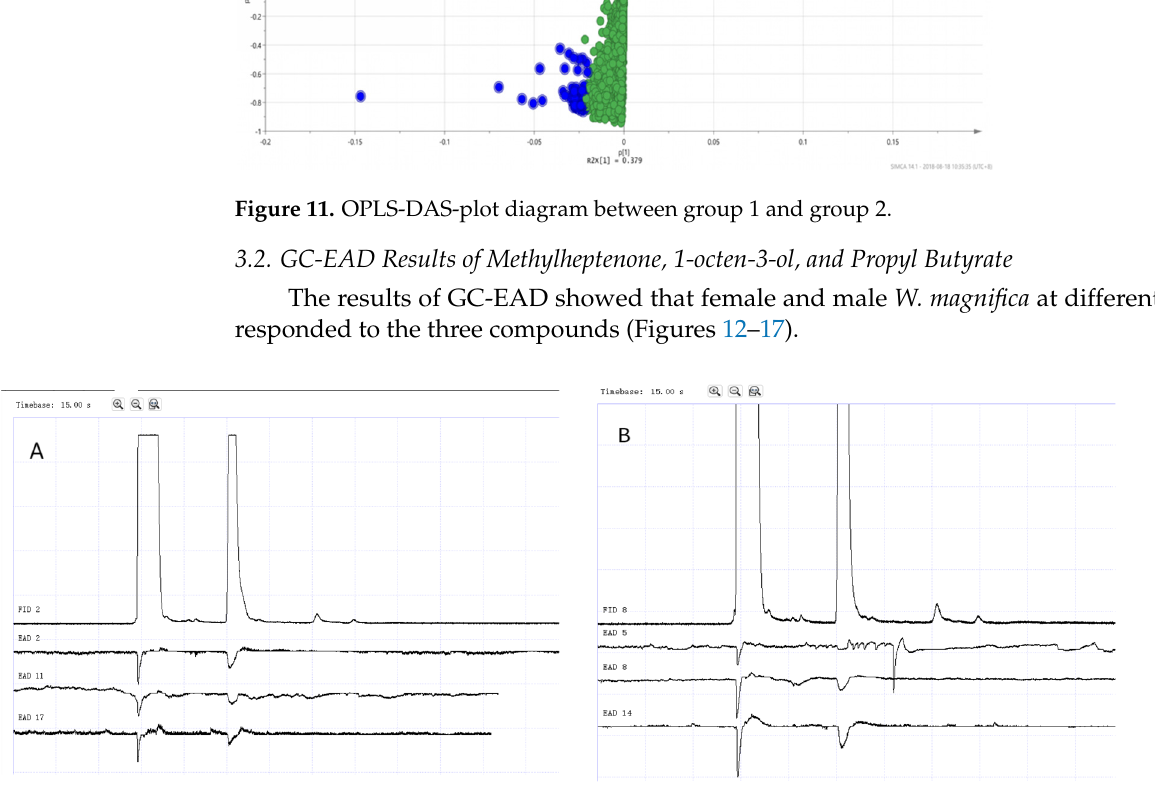
Figure 12. GC-EAD responses of 1-day-old W. magnifica to methylheptenone. ( A ) Male. ( B ) Female.